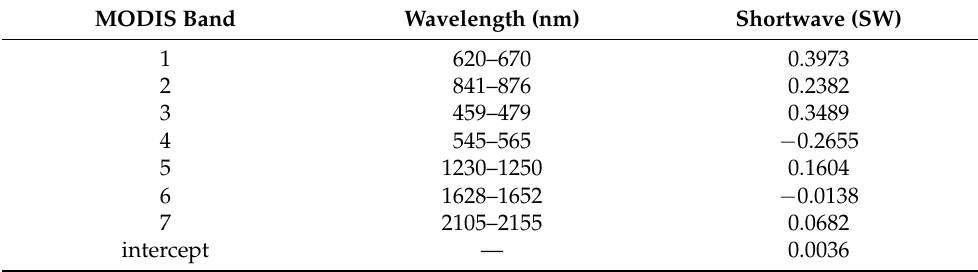
Table 4. Narrowband spectral-to-broadband albedo conversion coefficients from